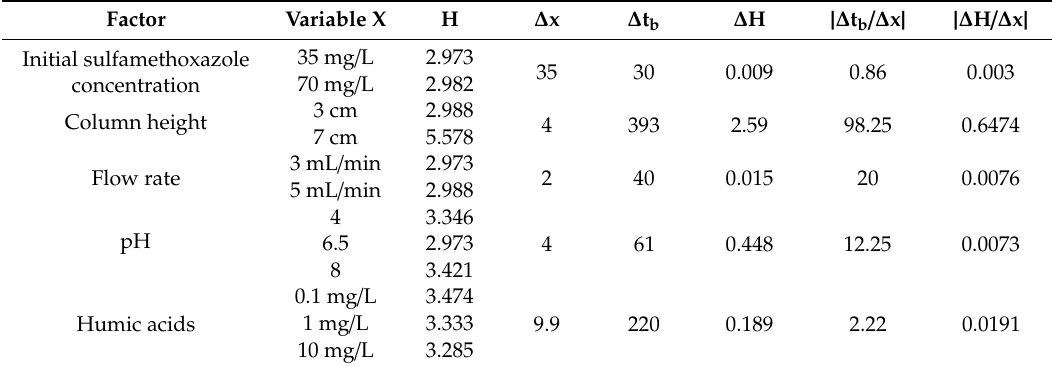
Table 4. Analysis of each factor on the length of the mass transfer zone of the activated coke adsorption sulfamethoxazole dynamic column experiment.